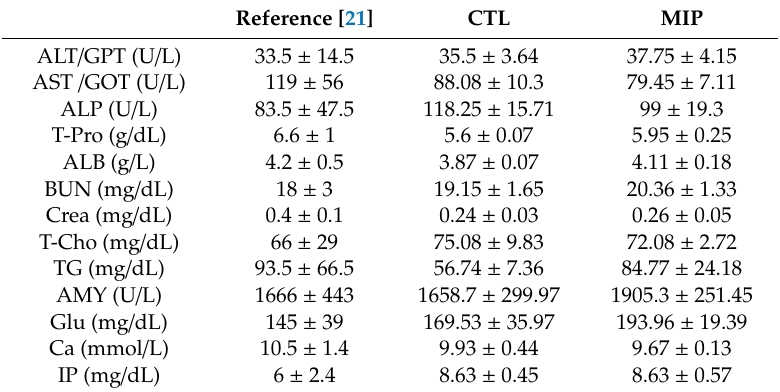
Figure 7. Body weight of rats after 28 day sub-aute oral toxicity testing with MIPs. CTL: control; MIP: mesoporous iron particles. All data are presented as mean ± SD ( n = 10).